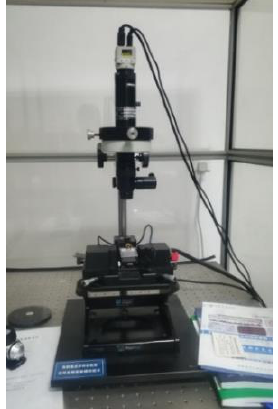
Table 2. AFM scanning parameters.